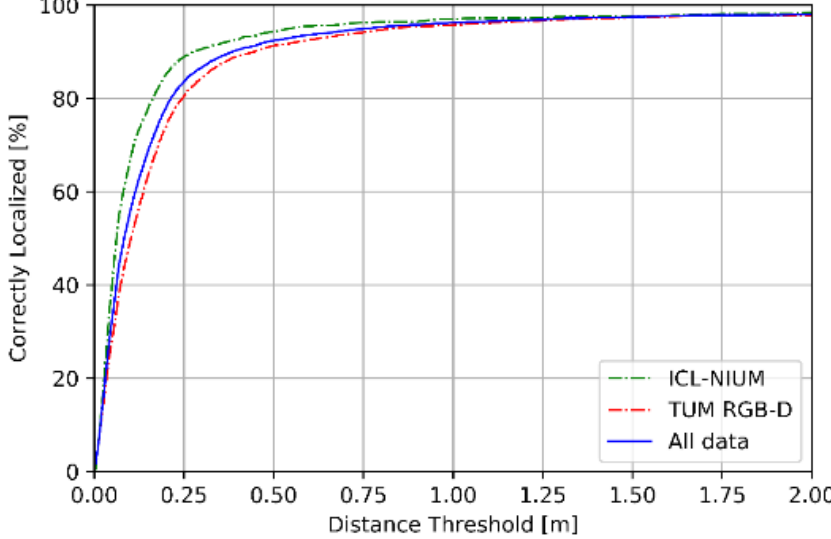
Figure 9. Cumulative distribution function of location error.